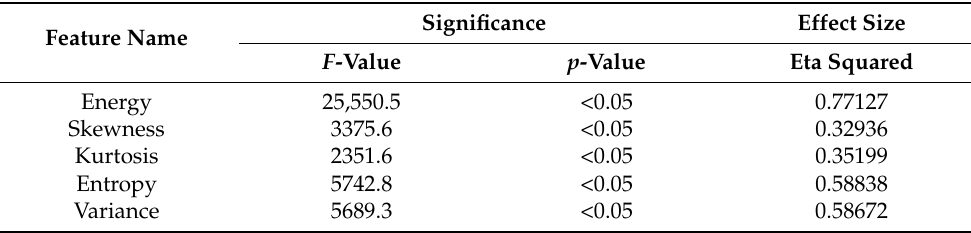
Table 3. The second step feature selection using one-way ANOVA. Significant features are identified based on p -value < 0.05, and large effect